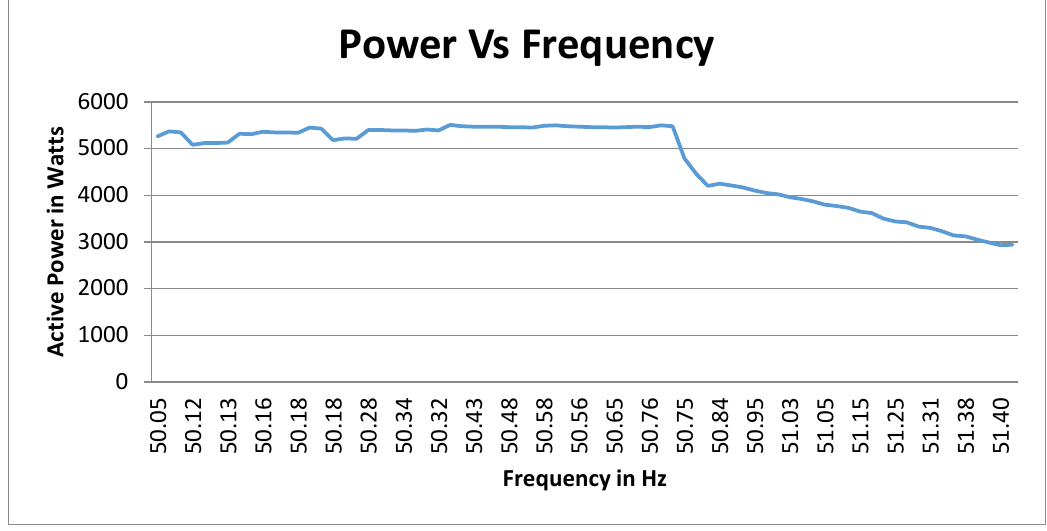
Figure 19. Experimental test set up with EMS controller and DES with load banks.